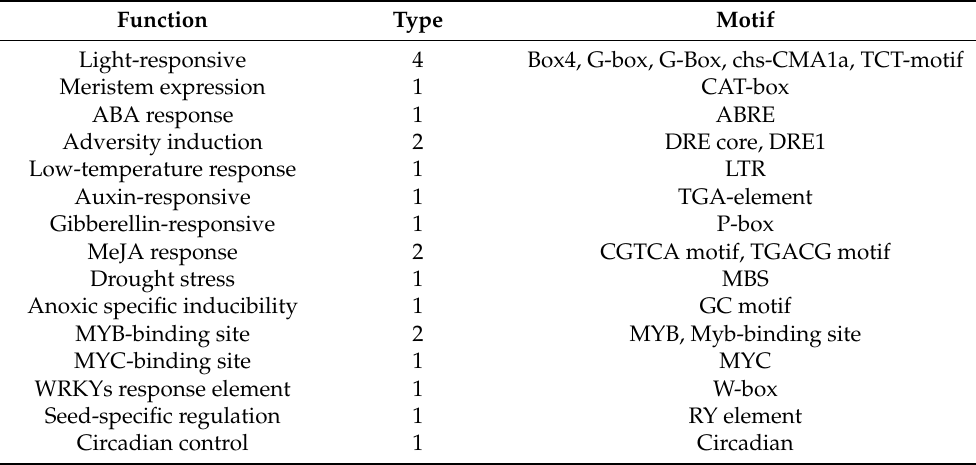
Table 2. Cis-regulatory elements of FaZAT10 promoter in cultivated strawberry. Function